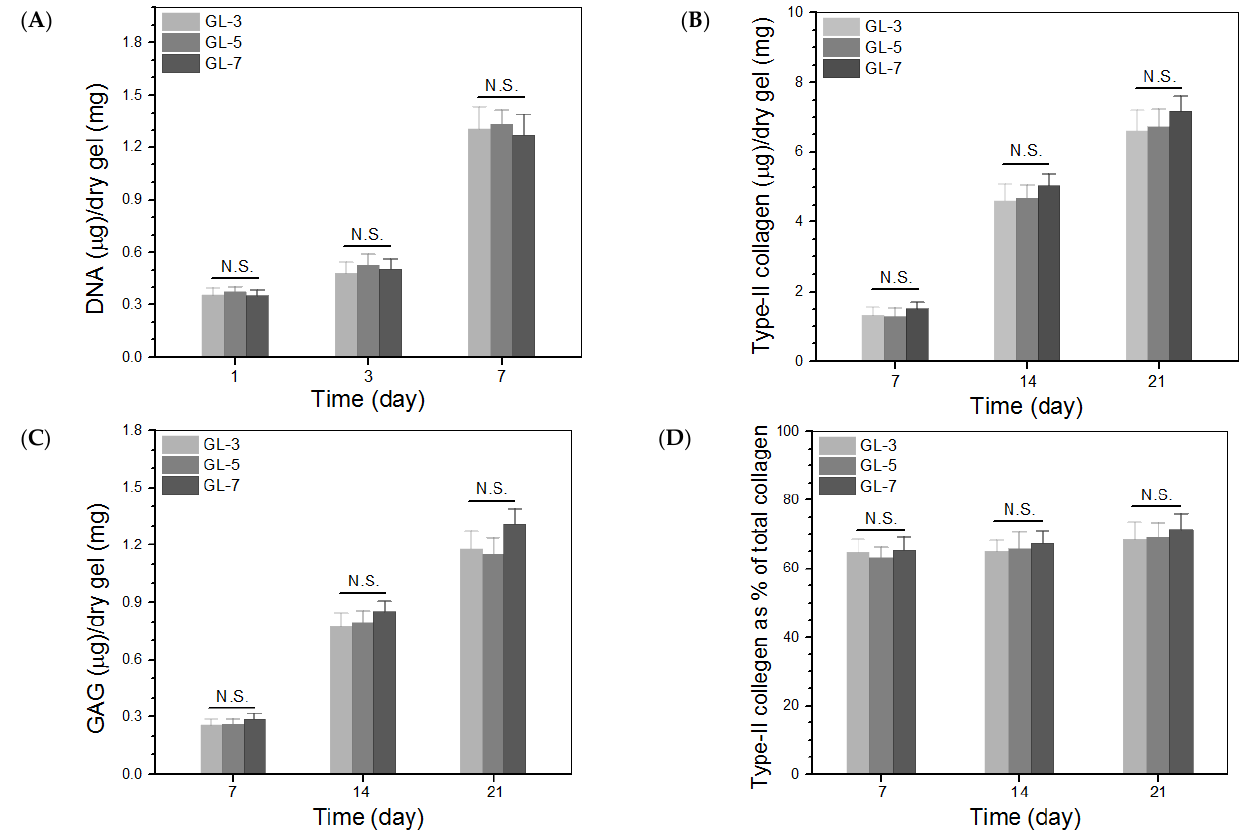
Figure 6. DNA amounts detected from cell-gel constructs ( A ), measured amounts of type II collagen and glycosaminoglycan (GAG) in gels ( B , C ), and percentage of type II collagen in total collagen for gels ( D ) (N.S., not significant).